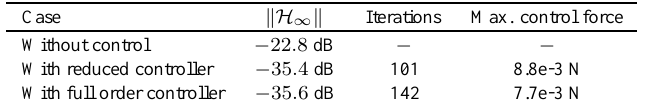
Table 1 H ∞ norm, iterations number and control force for each case